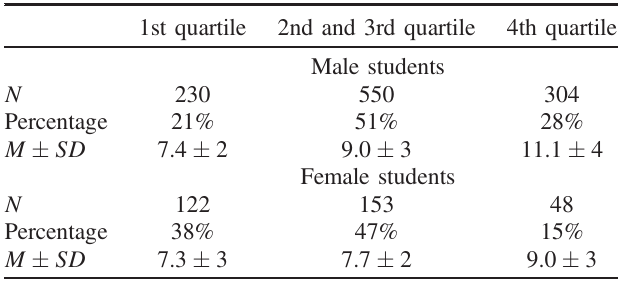
TABLE III. Male and female student CPP/NonQnt by